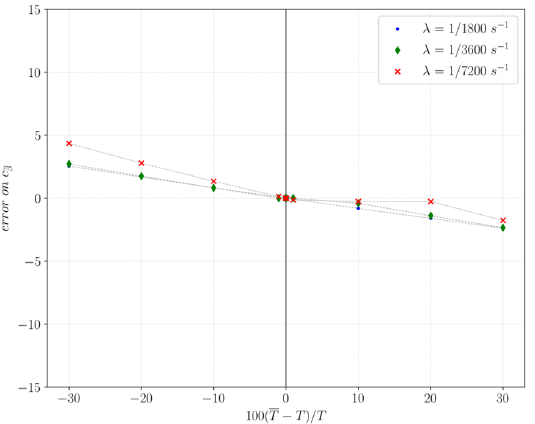
Figure 10. Percentage variation of the cost : 𝜆 = 1 (cid:3403) 1800 s (cid:2879)(cid:2869) (circles), 𝜆 = 1 (cid:3403) 3600 s (cid:2879)(cid:2869) (diamonds), 𝜆 = 1 (cid:3403) 7200 s (cid:2879)(cid:2869) (crosses), 𝛽̅ = 0.995 .